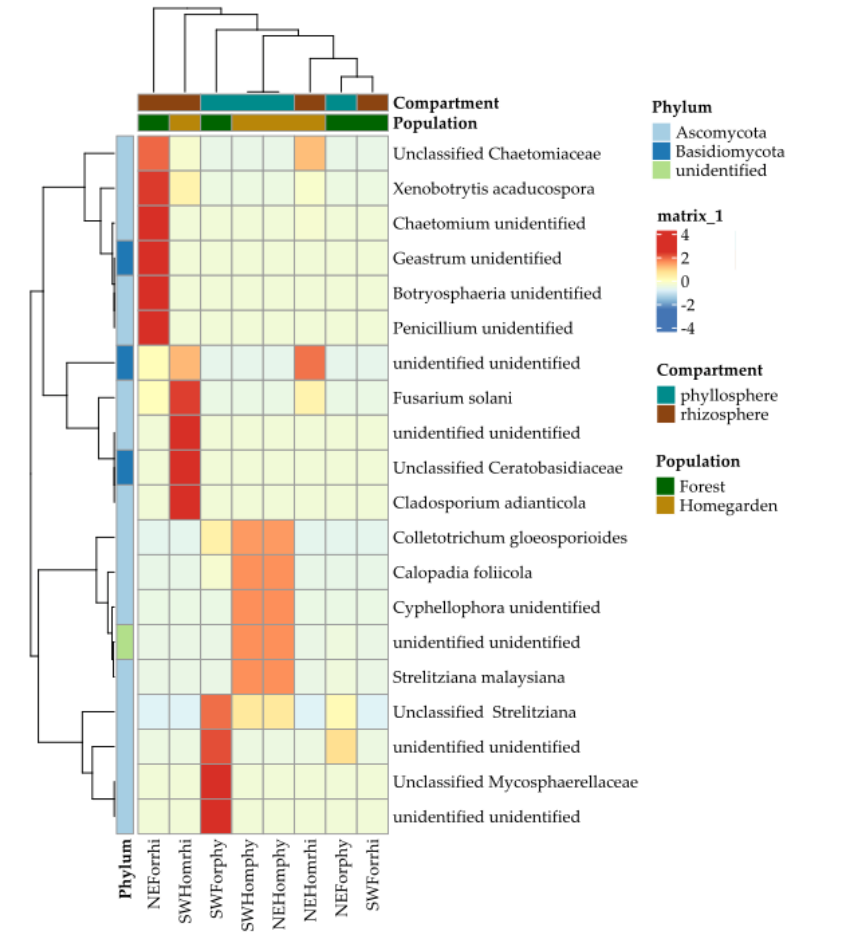
Figure 8 . Heatmap of the fungal microbiota from the phyllosphere and rhizosphere in Yucatán´s forest and homegarden populations of Cordia dodecandra .